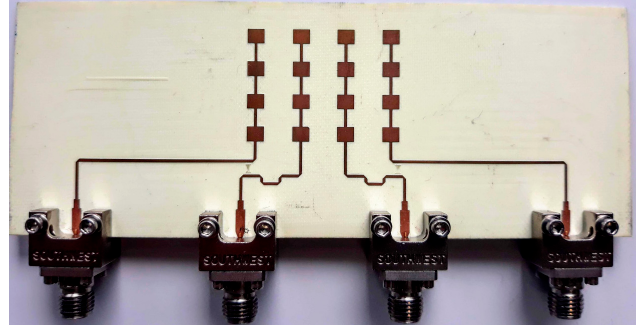
Figure 9. Planar antenna array 4 × 4.